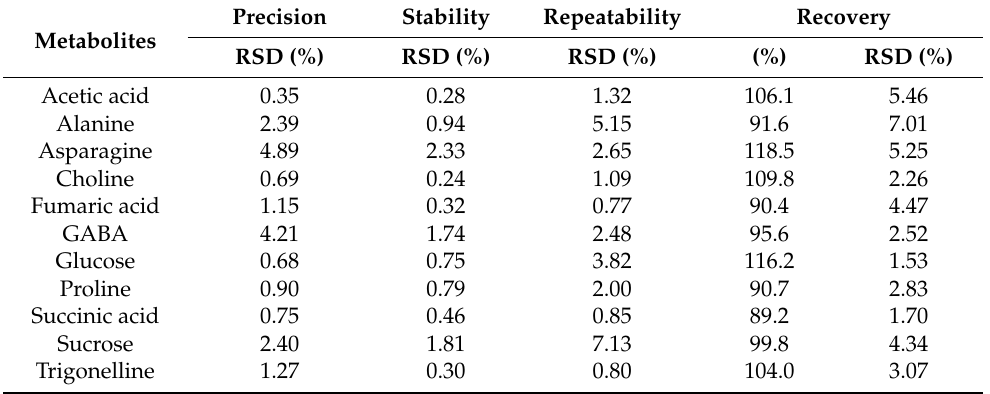
Table 3. The methodological investigation results of precision, stability, repeatability and recovery ( n =